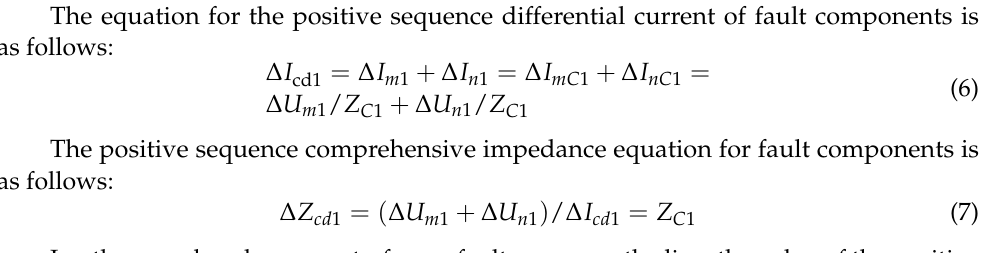
Figure 5. Positive sequence fault component network diagram for out-of-zone faults.